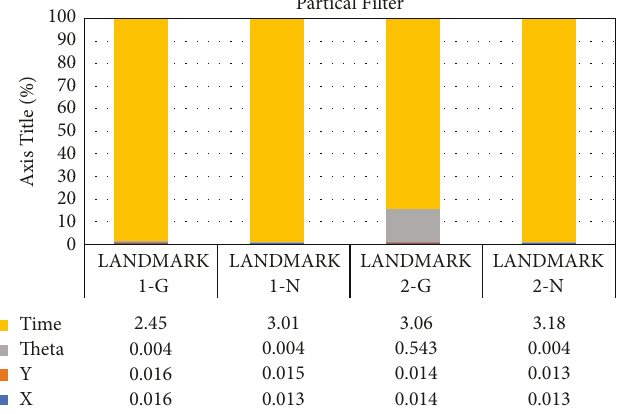
Figure 22: Simulation results analysis of PF.